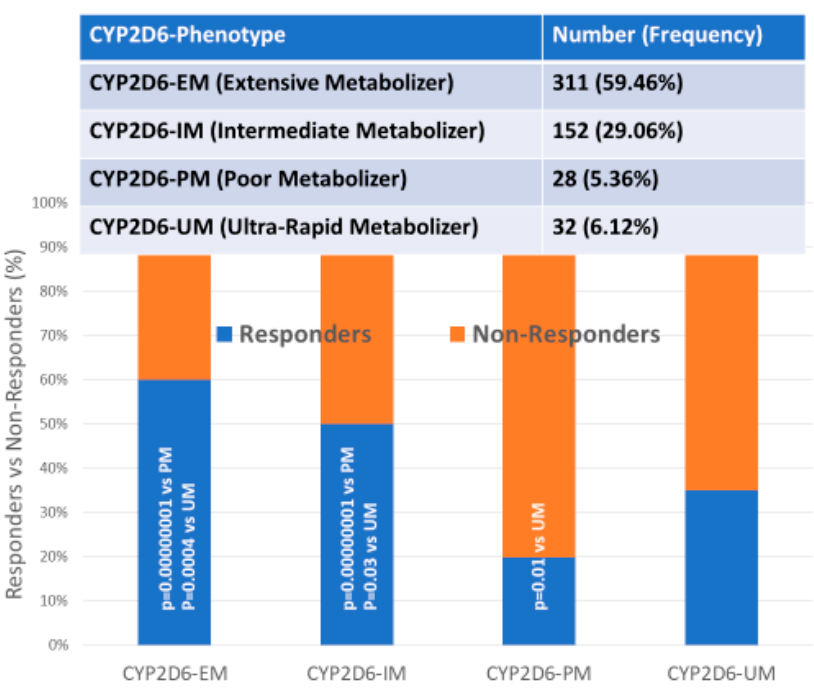
Figure 6. CYP2D6-related responder/nonresponder rate in patients with Alzhimer’s disease treated with a multifactorial/combination treatment for one year. Responders: Final MMSE score > basal MMSE score. Nonresponders: Final MMSE score < basal MMSE score. Data Source: Cacabelos et al., 2019.